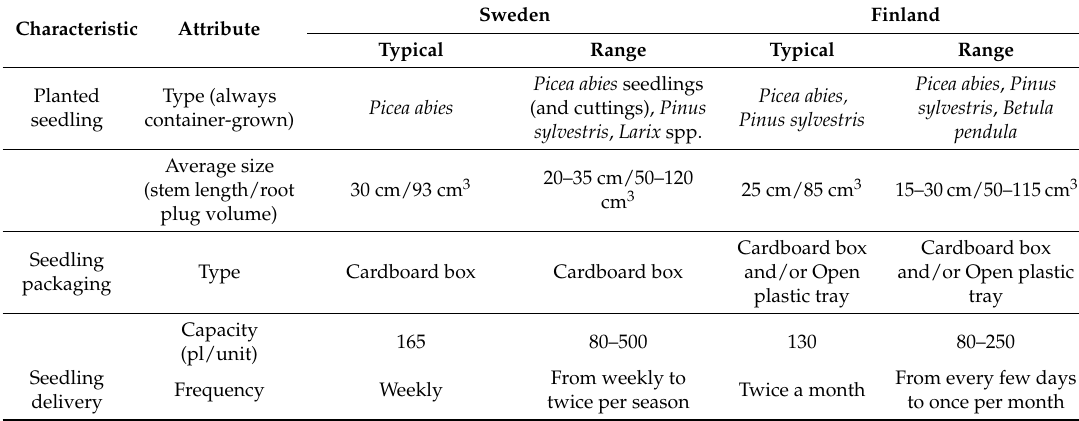
Table 3. Characteristics of seedling logistics for mechanized tree planting in 2017 in Sweden and Finland (pl = seedlings). Words enclosed by (brackets) in the ‘Range’ columns indicate that the circumstance sometimes